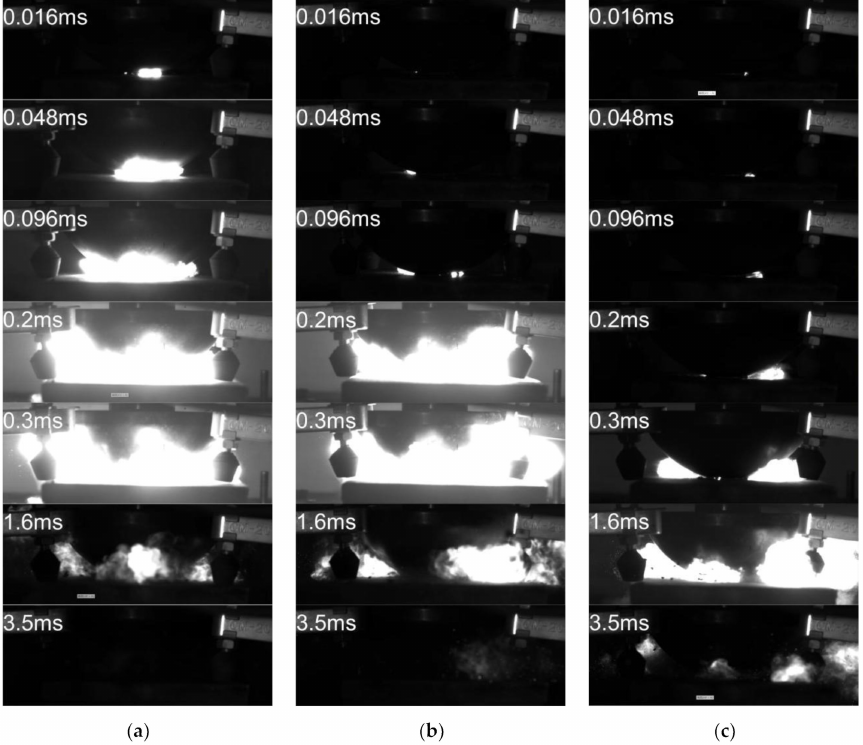
Figure 7. Typical pattern impact reaction process. ( a ) PTFE/Al; ( b ) PTFE/Al/CuO; ( c ) PTFE/Al/Ni 2 O 3